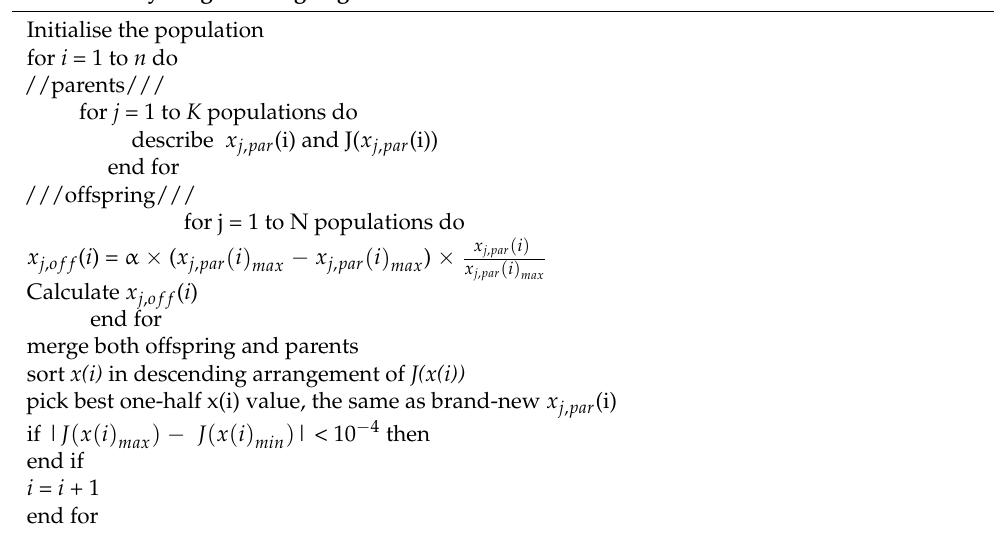
Table 3. Pseudocode of EP. Evolutionary Programming Algorithm